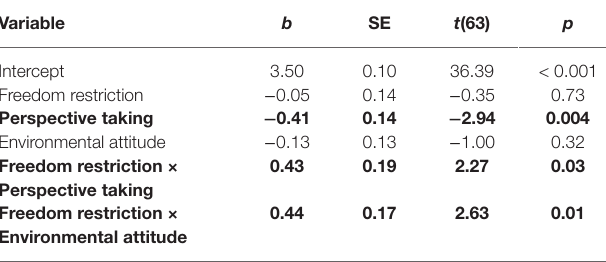
TABLE 4 | Moderation analyses or variables predicting action evaluation ( N = 65) in Study 2. Variable